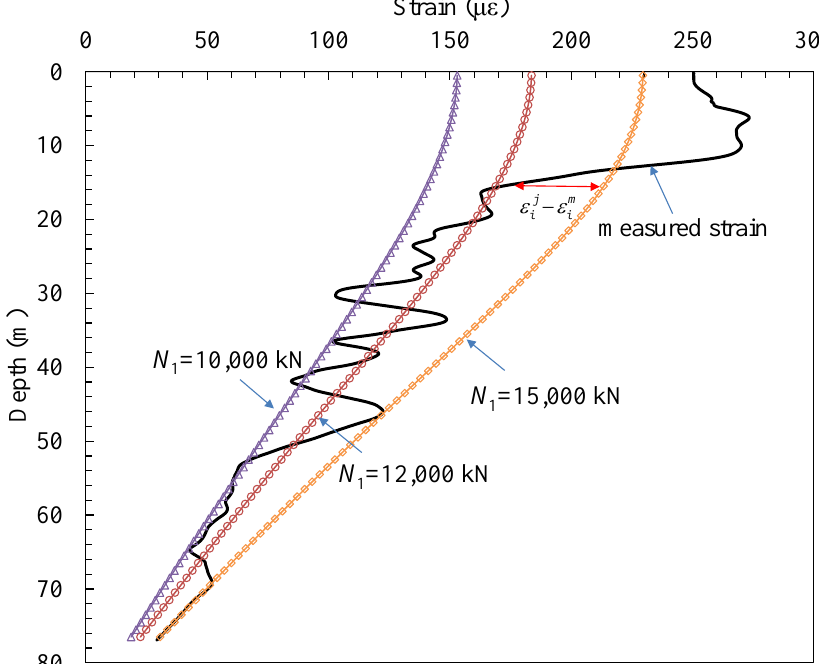
Figure 10. Determination of the load at the pile head by the minimum Euclidean